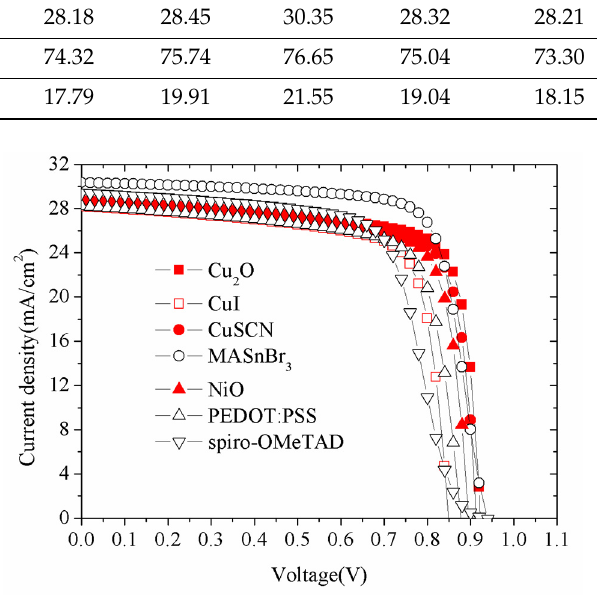
Figure 5. E ff ect of di ff erent HTL materials on J-V Figure 5. Effect of different HTL materials on J-V characteristics.